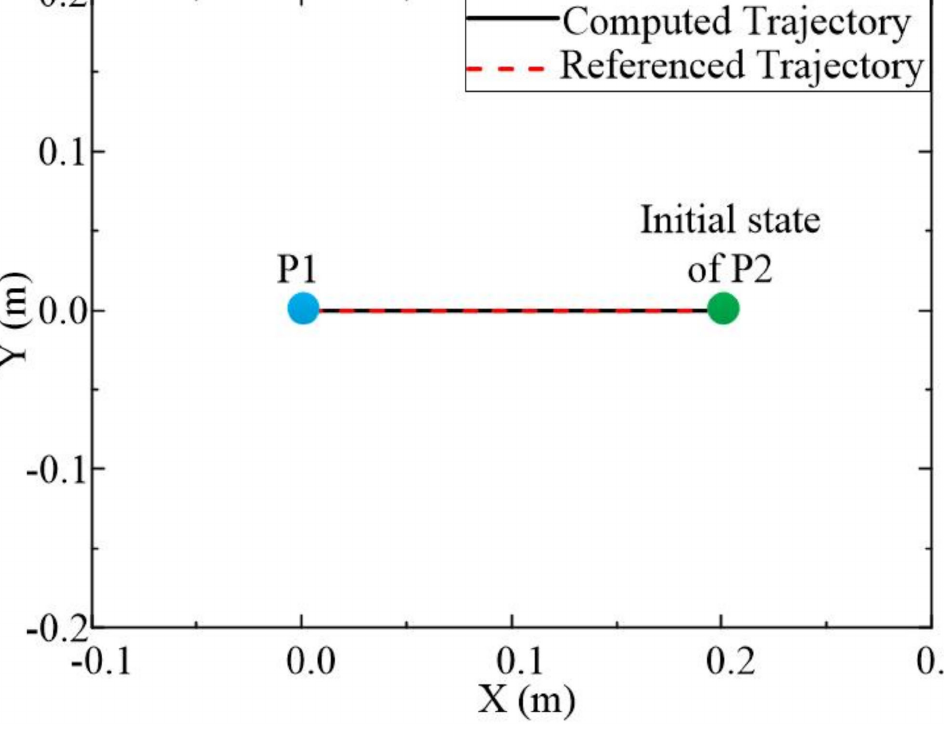
Figure 27. Trajectory of P2 in the end-effector 1